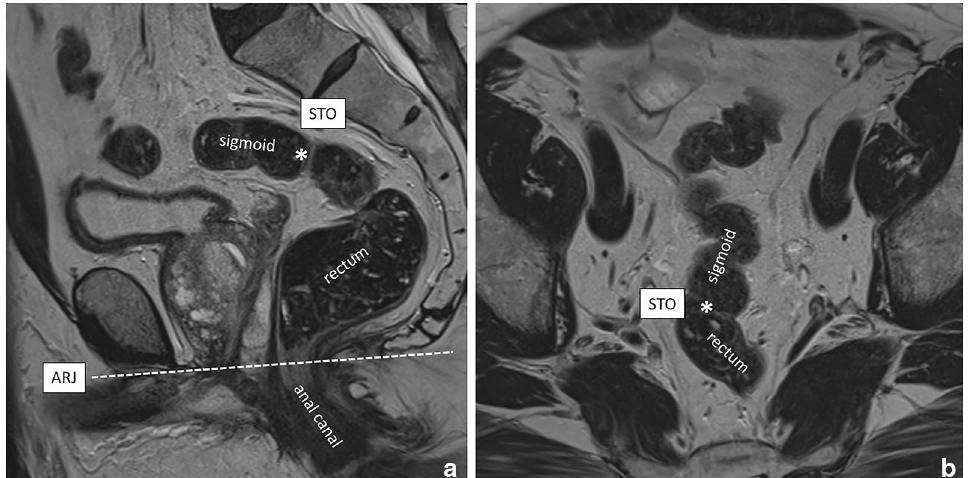
Fig. 3 Sagittal and axial T2‑weighted images of a normal rectum of a male individual (without rectal cancer) demonstrating the sigmoid take‑off (STO, indicated by the *) as the point from which the sigmoid sweeps horizontally on a sagittal view ( a ) and ventrally on an axial view ( b ), away from the sacrum. The white dashed line on the sagittal view indicates the anorectal junction (ARJ) that is typically situated at the level of an imaginary line between the lower margin of the sacral and pubic bone